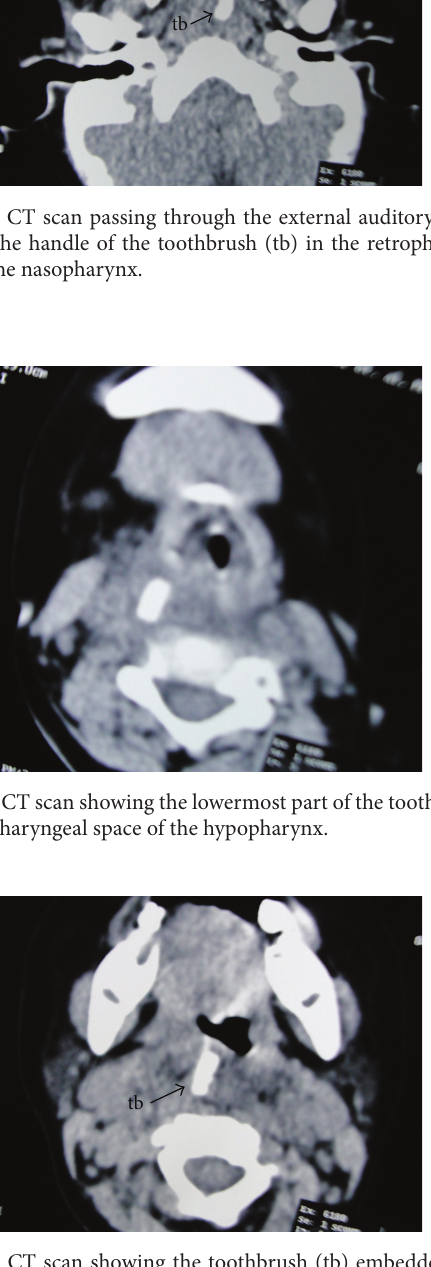
A zero degree nasal endoscope was introduced through the left nostril. After cleaning by suction, a portion of the handle was found to be protruding from the posterior wall of the nasopharynx on the left side but both ends of the toothbrush were firmly embedded within the soft